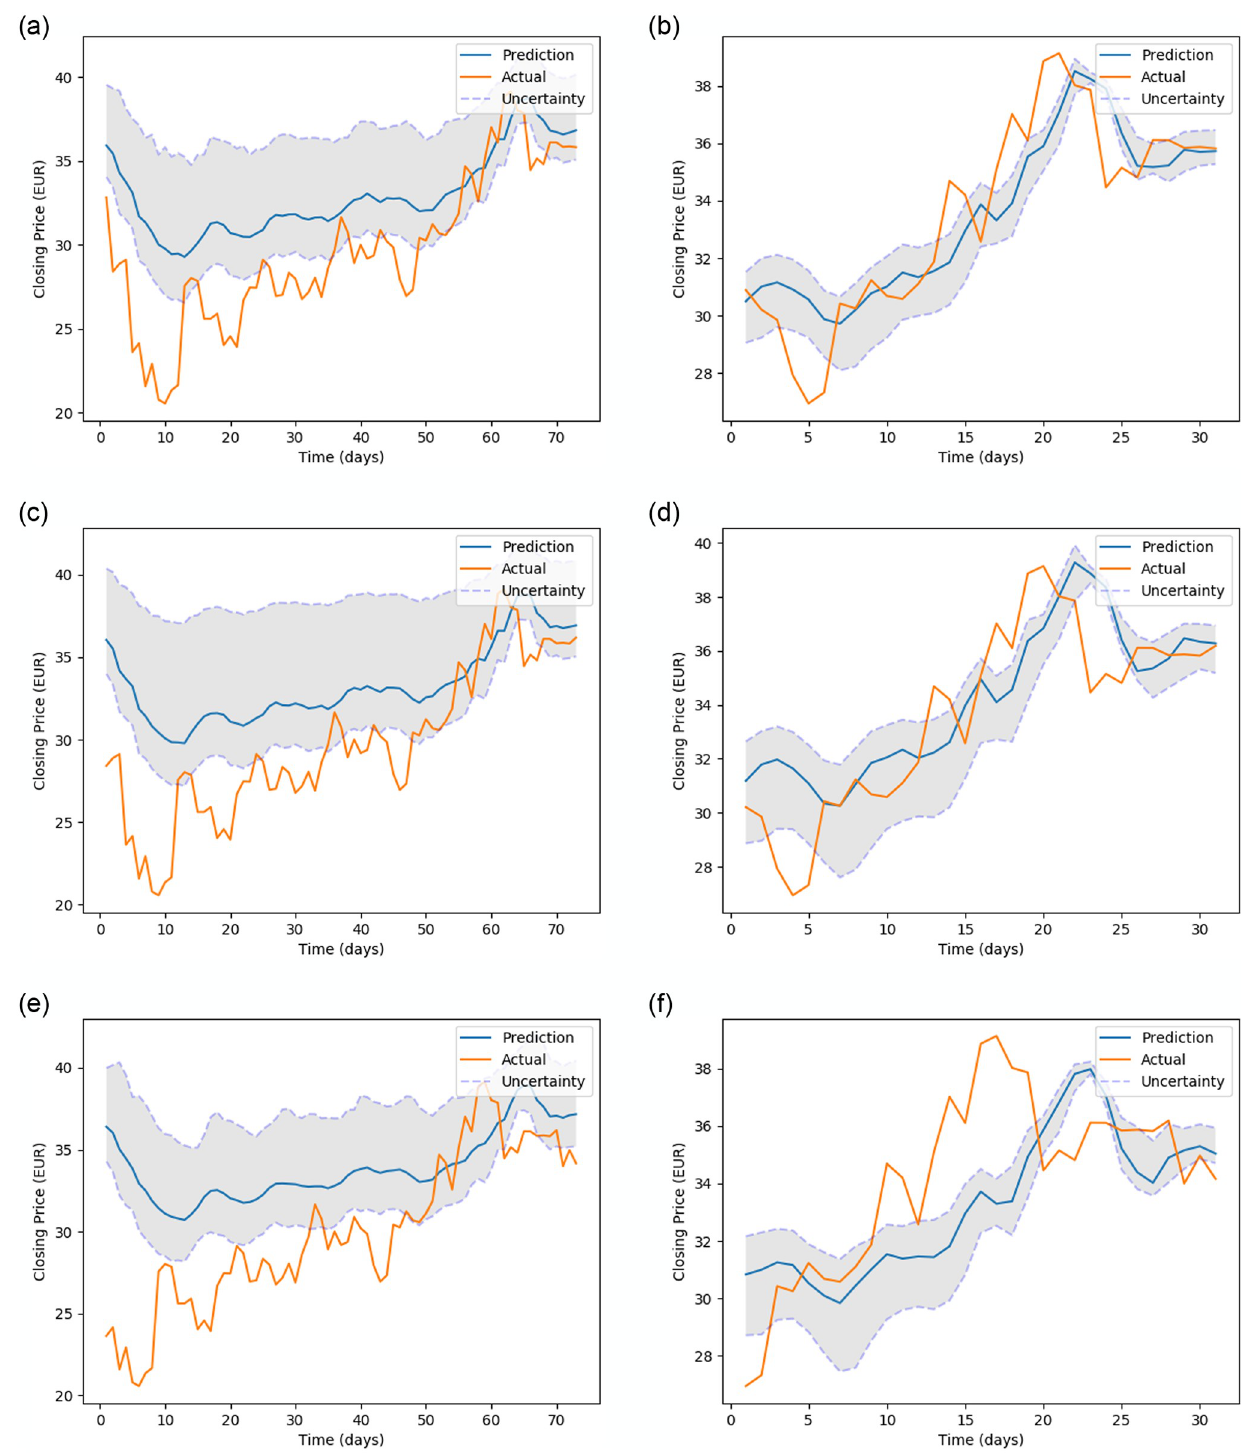
Fig 13. Prediction and uncertainty over test data of DAI.DE (data setup 1 vs data setup 2).